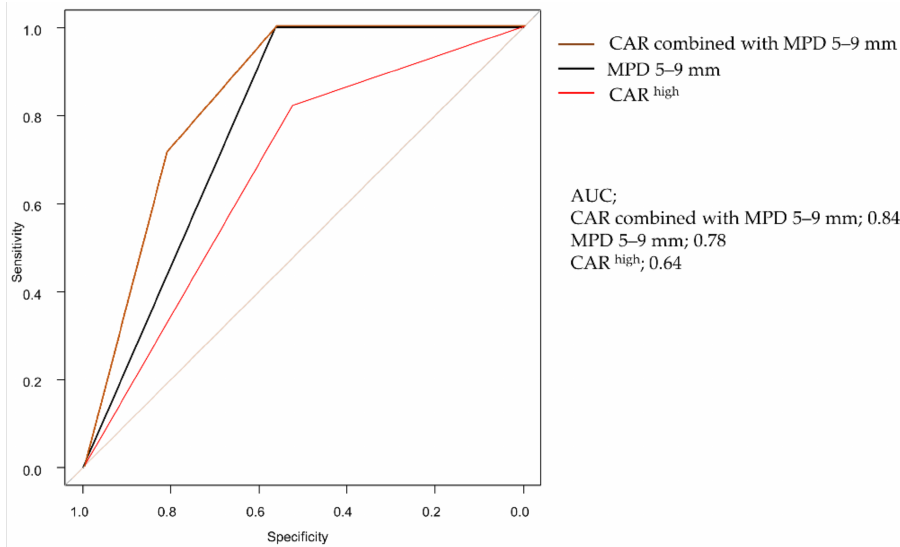
Figure 5. Receiver operating characteristics (ROC) curve for CAR high combined with Main pancreatic duct (MPD) 5–9 mm, MPD 5–9 mm and CAR high . CAR high combined with MPD 5–9 mm is